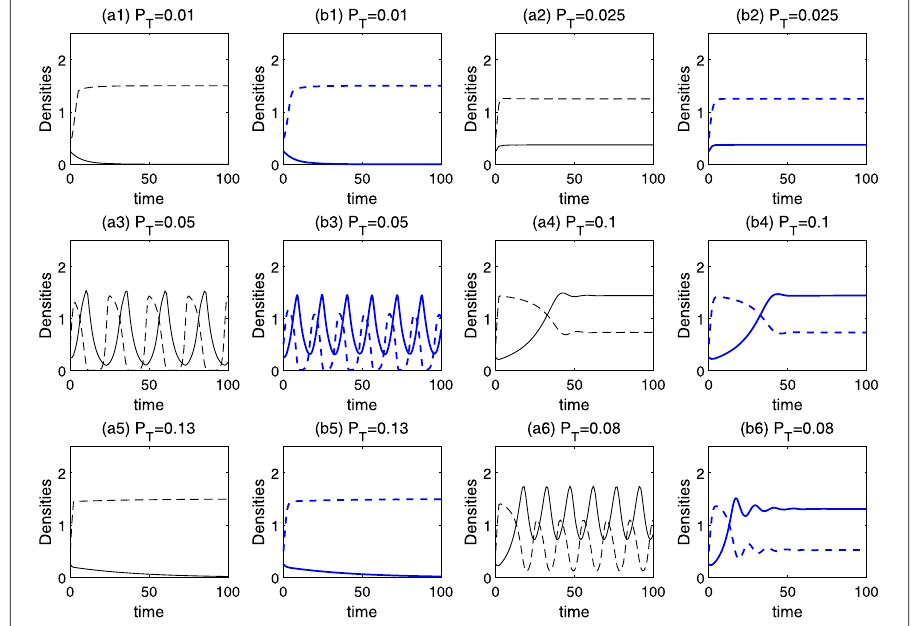
Figure 2 Solution curves for systems (5.1) and (5.2). The parameters are defined in Table 1, and the initial conditions are x = 0.5 mg C/L and y = 0.25 mg C/L. ( a i ) and ( b i ) denote the dynamics of (5.1) and (5.2) with different P T , respectively. Producer and grazer densities (mg C/L) are given by dashed and solid lines,